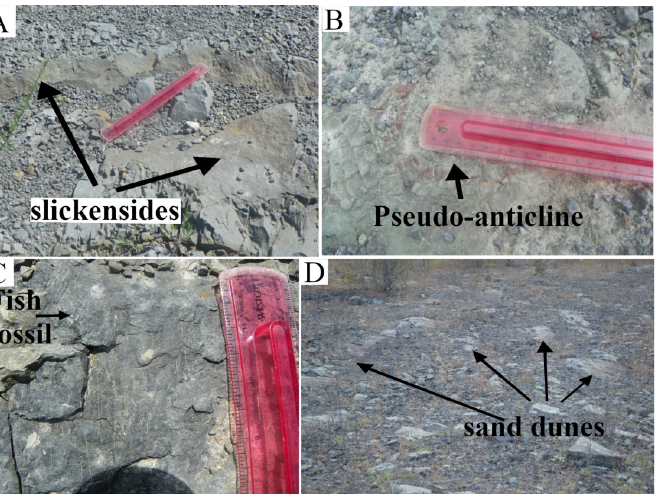
Fig 16. The main features of the paleosol along the G-H section. Interestingly, the areas along G-H sections have both vertic and hydromorphic features. (A) A slickenside at the paleosol surface (vertic feature, also young paleosol). (B) A pseudo-anticline (vertic feature) with oxidized boundary (hydromorphic features). (C) A fish fossil that helps correlate it with light-olive green siltstone at the C-D section. (D) The sand dunes deposit overlying the hydromorphic